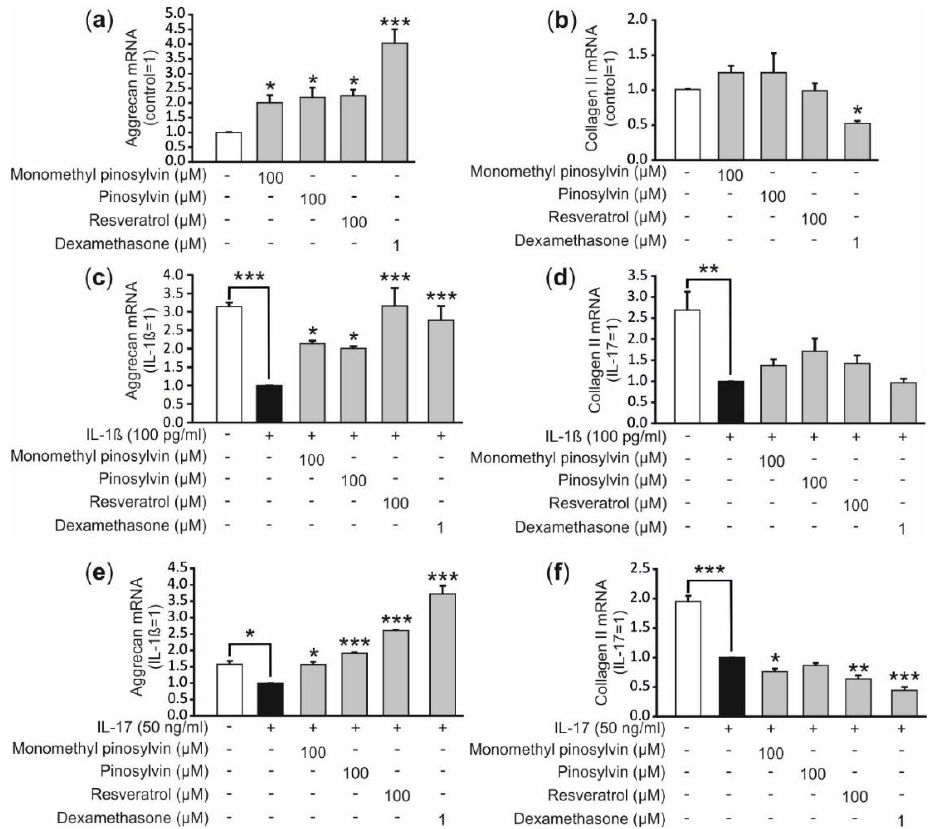
Figure 5. Effects of monomethyl pinosylvin, pinosylvin, resveratrol and the anti-inflammatory control compound dexamethasone on aggrecan and collagen II expression. Human primary chondrocytes were cultured with the tested compounds alone ( a , b ) or with IL-1 β ( c , d ) or IL-17 ( e , f ) for 24 h before RNA was extracted. Aggrecan and collagen II mRNA was determined by reversed transcriptase polymerase chain reaction (RT-PCR) and the results were normalized against GAPDH mRNA. Primary chondrocytes were isolated from cartilage samples obtained from three consequent donors and the experiments were performed in duplicate; n = 3 was used in the calculations. Results are expressed as mean +SEM. * p < 0.05, ** p < 0.01 and *** p < 0.001 as compared to cells non-stimulated or treated